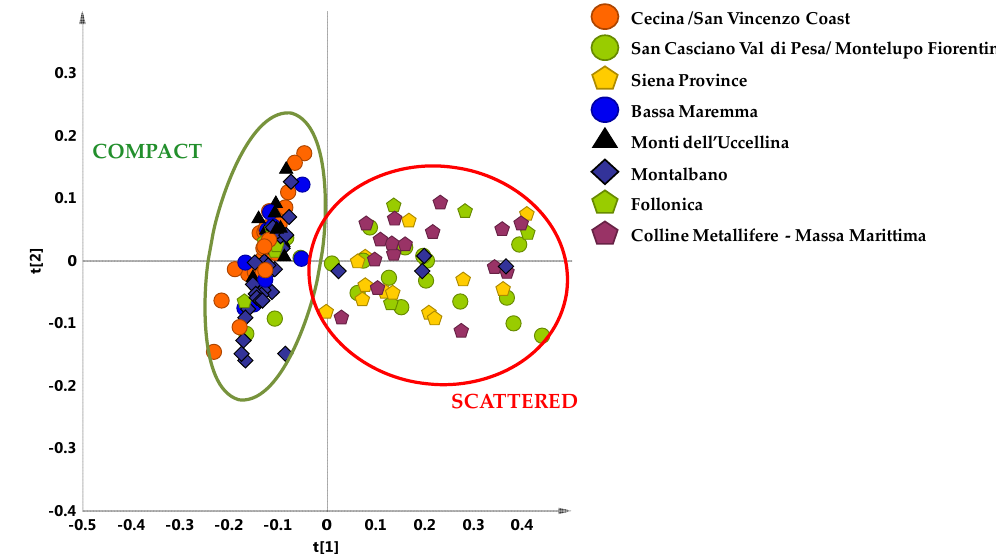
Figure 3. PCA t[1]/t[2] scores plot for micro-milled olive oil samples from the main geographical origin area (t[1] and t[2] explain 70% and 9% of the total variance, respectively). Compact and scattered macro groups were identified by green and red circles respectively.